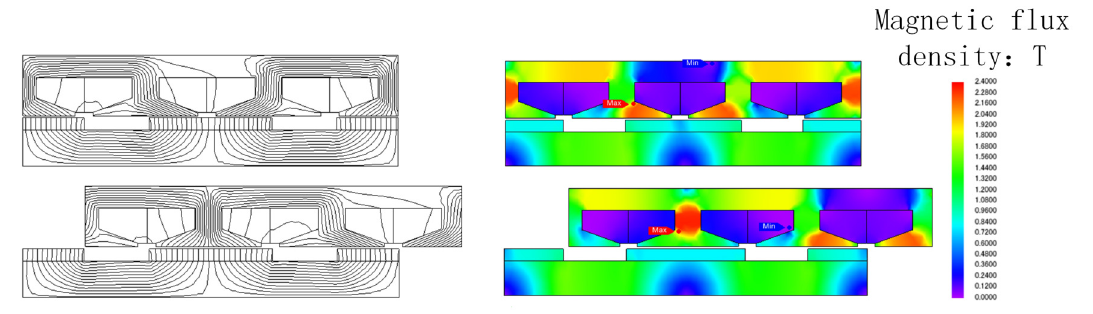
Figure 6. Magnetic field